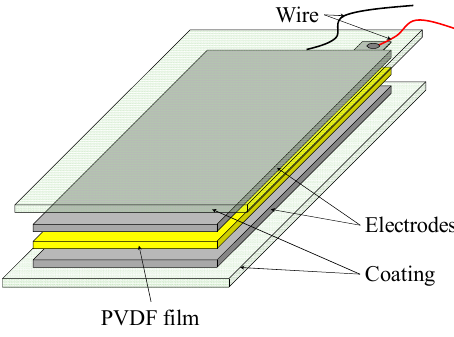
Figure 1. Schematic configuration of the PVDF sensor.